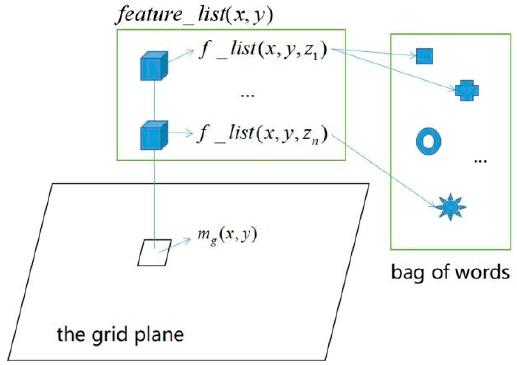
Figure 5. The expression of the proposed 2.5D map.